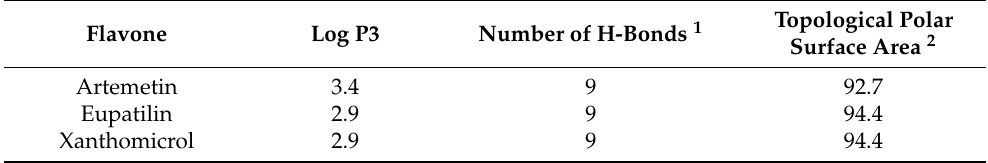
Table 1. Properties of flavones computed from chemical structure